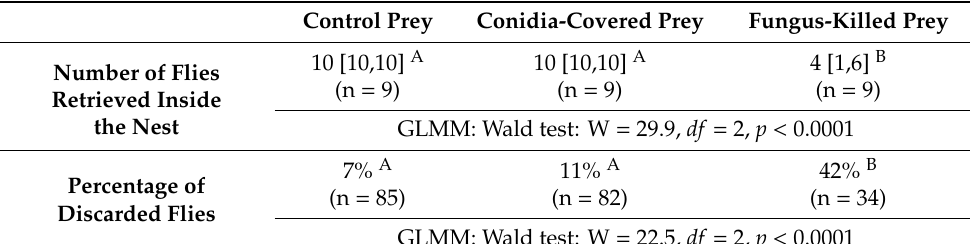
Table 1. Prey retrieval and prey discarding as a function of their infectious state. For the retrieved flies, median, first and third quartiles values are given. The discarded flies are expressed in percentage. After general linear mixed models (GLMMs), Tukey post hoc tests were made with Bonferroni correction. Values sharing a common letter were not significantly different.